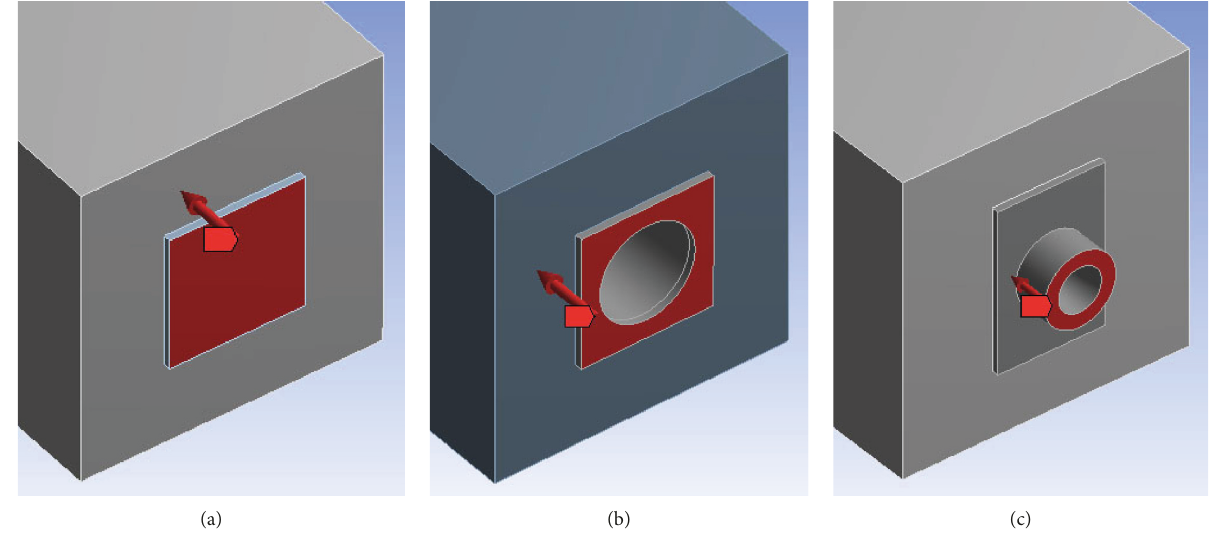
Figure 4: Dimension and loading on the bearing plate. (a) Model S, (b) Model C, and (c) Model